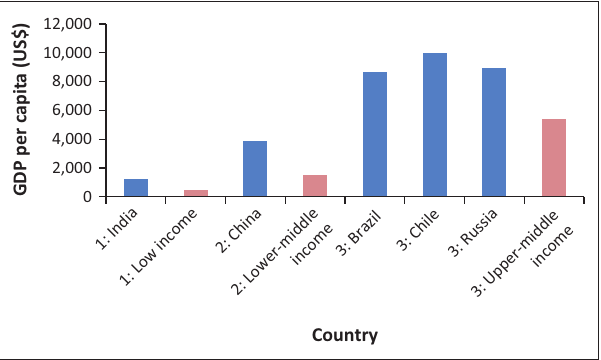
FIGURE 1: GDP/per capita for lower- and upper-middle income countries,